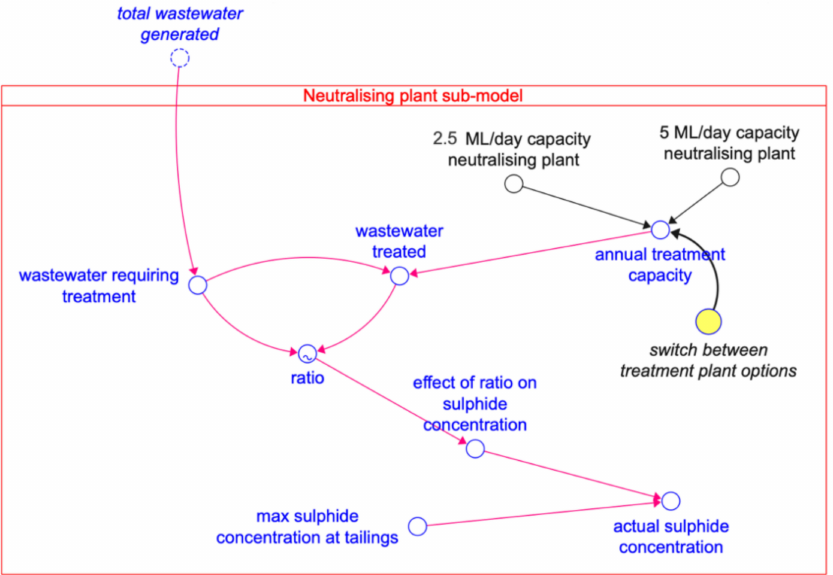
Figure 6. Sub-model 4 represents groundwater (GW) in Pilgrim’s Rest and GW contamination risk from gold mining. Variables with the ‘~’ symbol denote either graphical functions or where a LOOKUP data table is behind the